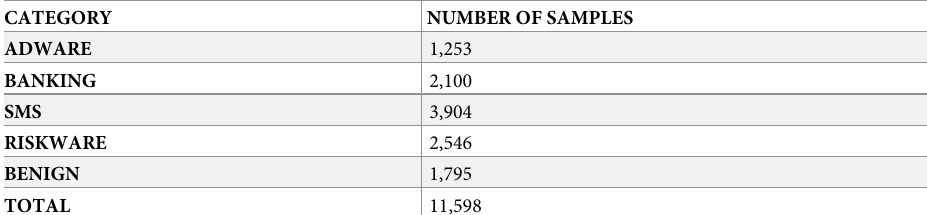
Table 4 lists private parameter settings of each metaheuristic optimization algorithm